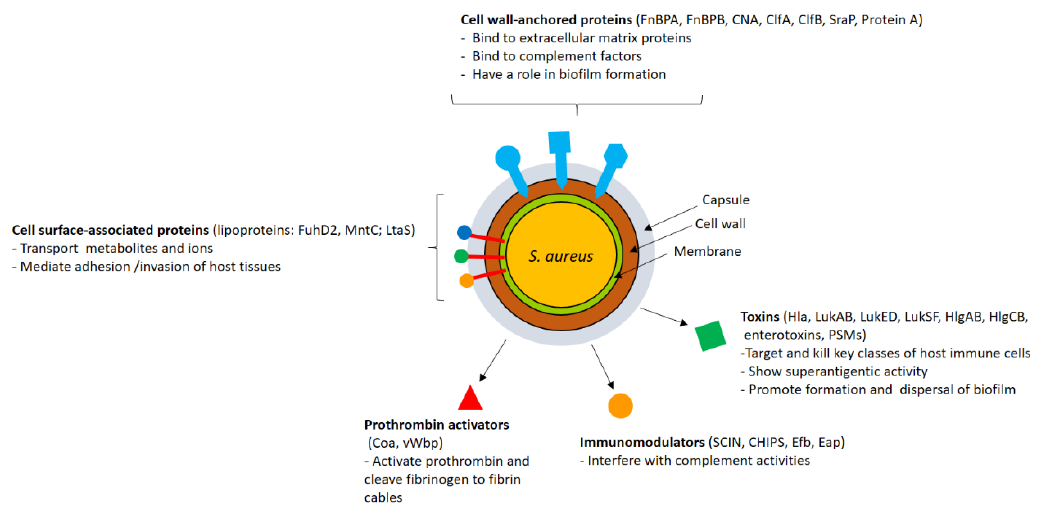
Figure 1. Schematic representation of the Staphylococcus aureus surface and secreted virulence factors . S. aureus is endowed with a large arsenal of surface-expressed and secreted virulence factors that are targeted by the host immune system. These targets include (a) cell-wall-anchored proteins that promote adhesion to extracellular matrix proteins, binding to complement proteins and biofilm formation; (b) surface-associated proteins anchored to the cell membrane and involved in processes such as transportation of metabolites and ions and enzymatic and ligand-binding activities; and secreted factors, which include leukocidal toxins and superantigens, autolysins, prothrombin activators and modulators of the complement pathways.